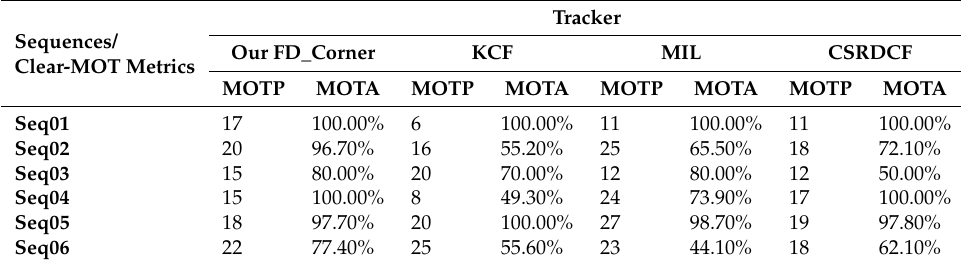
Table 5. Comparison of the baseline and stare of art trackers with FD corner: Clear-MOT evaluation measurement (Multiple object tracking precision (MOTP) and multiple object tracking accuracy (MOTA) on each video sequence.